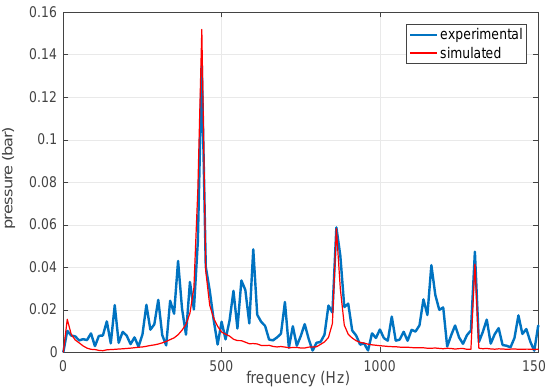
Figure 23. FFT of the pressure signal at 2000 rpm.